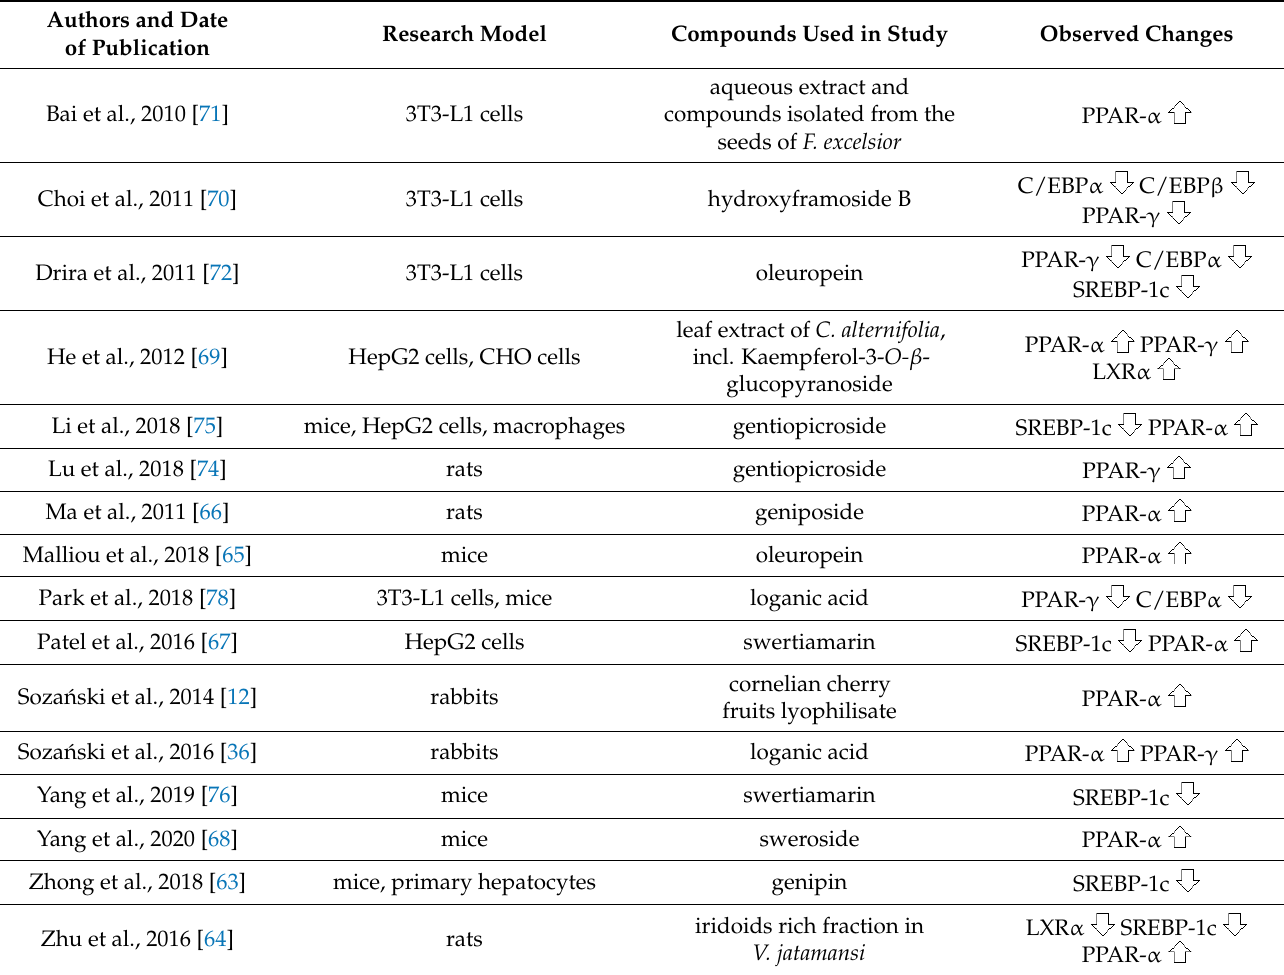
Table 2. List of studies describing the impact of iridoids on discussed transcription factors. Table 1. List of studies describing the impact of anthocyanins on discussed transcription factors.